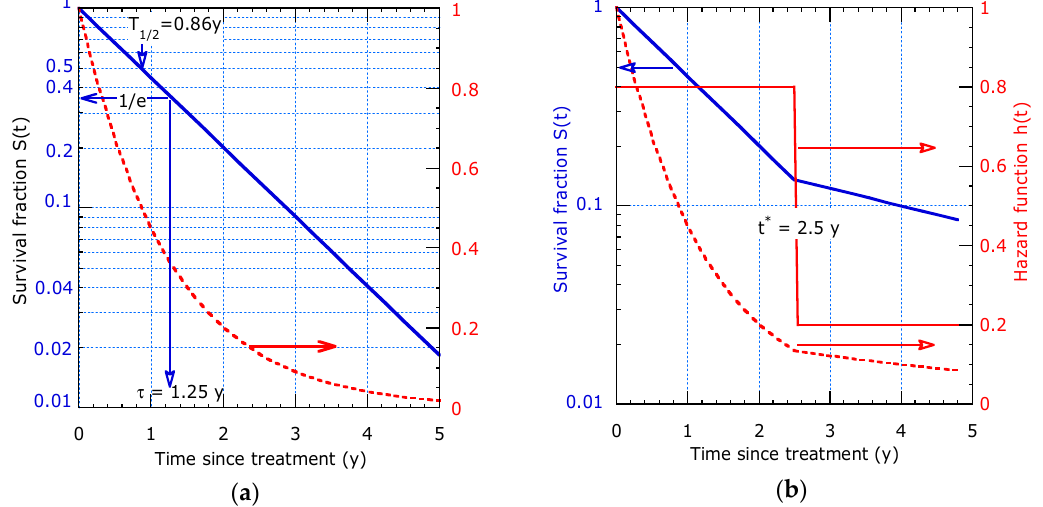
Figure 1. Exponential decay presented as: ( a ) Logarithmic plot providing a straight solid line for constant hazard (left scale) and as linear plot (dashed line, right hand scale); ( b ) Piecewise linear decay solid line on logarithmic scale (left) and dashed line on linear scale (right) with sudden transition at time t* = 2.5 y from a discontinuity in the hazard (right, h = 0.8 y − 1 for t < t * and h = 0.2 y − 1 for t > t * ).